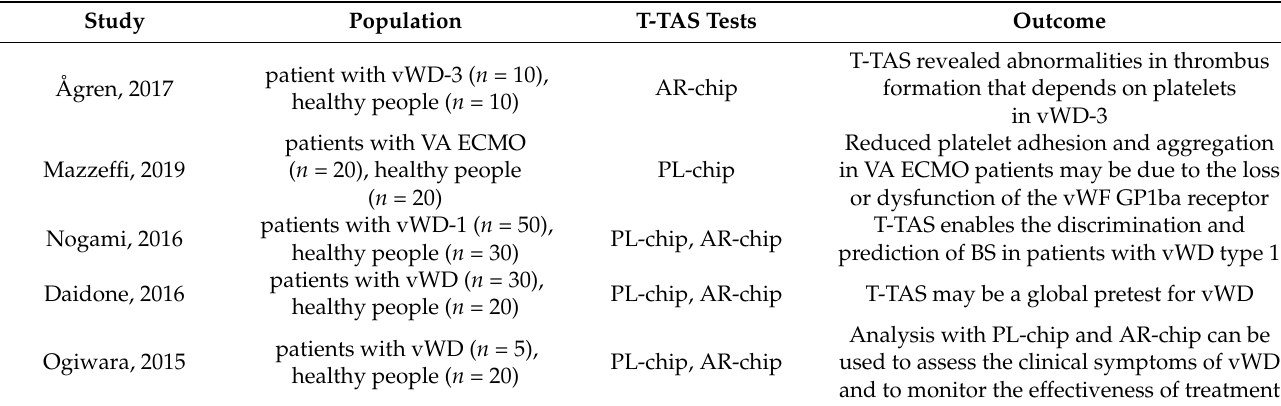
Table 5. Comparison of studies on the application of T-TAS with respect to the von Willebrand factor (BS—bleeding score calculated with the ISTH Bleeding Assessment Tool, GP1ba—platelet glycoprotein Ib alpha chain, VA ECMO—veno-arterial extracorporeal membrane oxygenation, vWD—von Willebrand disease, vWF—von Willebrand